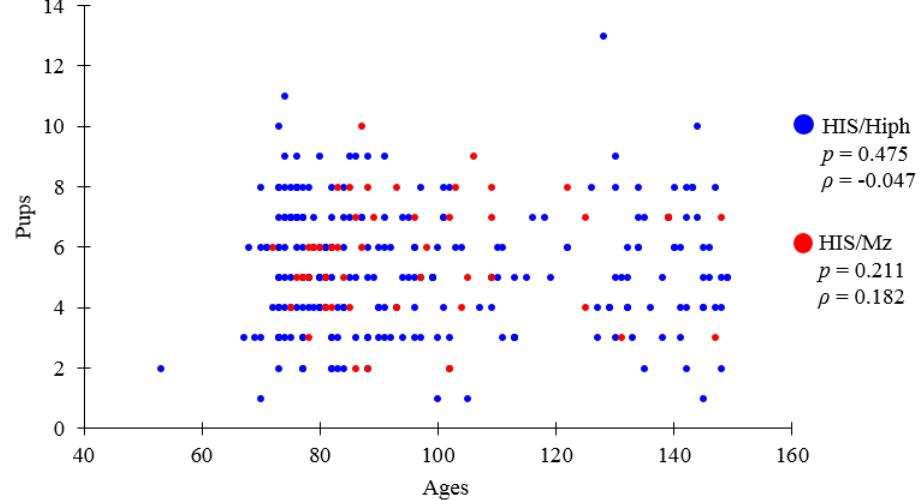
Figure 1. Numbers of pups and mother age in days at delivery. The total number of pups and mother age in days at delivery in the HIS/Hiph and HIS/Mz strains. Values are the mean ± standard error. Correlation between the number of pups and mother age in days at delivery in the HIS/Hiph and HIS/Mz strains. Spearman’s rank correlation coefficient ( n = 234 deliveries in HIS/Hiph and 49 deliveries in